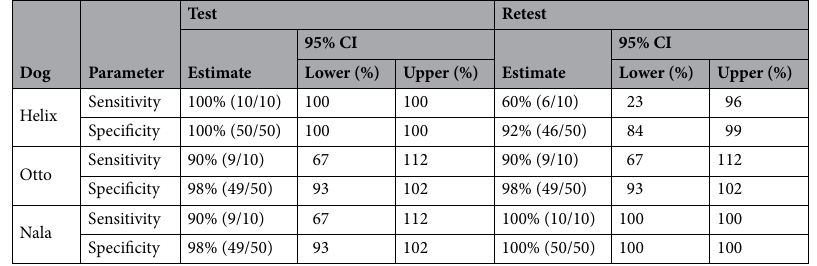
Table 1. Canine ability to detect COVID-19-related VOCs in the laboratory test and retest.